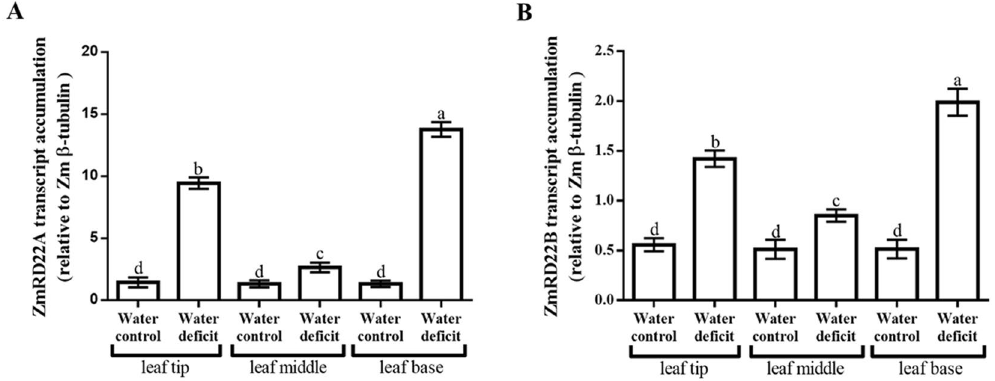
Figure 6. Expression of ZmRD22A and ZmRD22B in various regions of leaves in response to water deficit treatments. ( A ) Transcript accumulation of ZmRD22A in various leaf regions of the 2 nd youngest leaves of maize seedlings subjected to water deficit were measured by qRT-PCR. Leaf regions examined were the tips of leaves, middle of the leaves and the base of the leaves. ( B ) Expression of ZmRD22A in various leaf regions of the 2 nd youngest leaves of maize seedlings in response to water deficit. Expression was evaluated by qRT-PCR in the same leaf regions as in ( A ). Error bars signify standard errors of means from three independent experiments, bars with the same letters are statistically similar, where p <